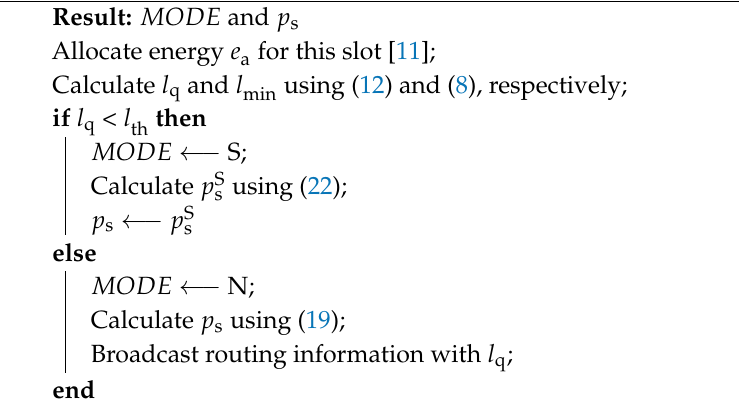
Algorithm 1: The operation of a dominant